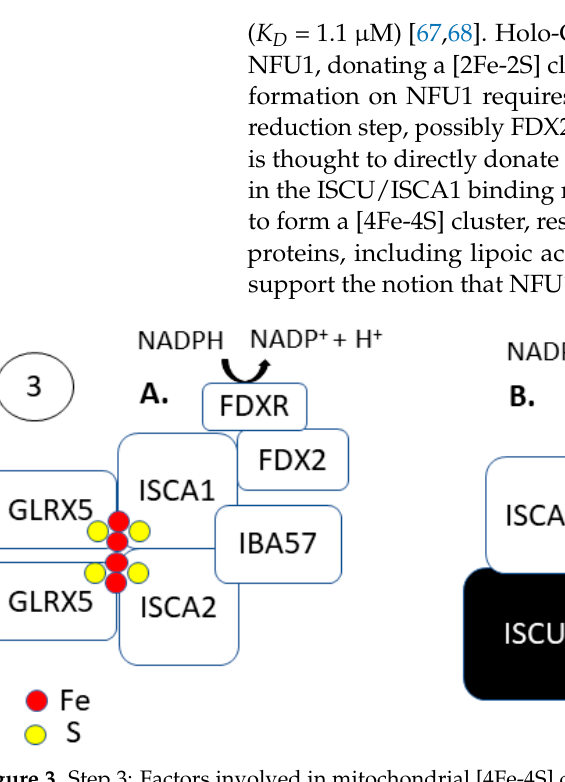
Figure 3. Step 3: Factors involved in mitochondrial [4Fe-4S] cluster formation. ( A ) Following [2Fe-2S] cluster formation and transfer to GLRX5, 2 molecules of holo-GLRX5 can bind with ISCA1/2. The formation of a heterodimer of [2Fe-2S]-ISCA1/2 allows for IBA57 and FDX2 dependent [4Fe-4S] assembly. ( B ) Following [2Fe-2S] cluster formation on ISCU, holo-ISCU and holo-ISCA1 can bind at the C-terminal domain of NFU1 to allow for [4Fe-4S] cluster formation on NFU1 in an FDX2-dependent manner. ( C ) Following the transfer of a [2Fe-2S] cluster from ISCU to GLXR5, a holo-GLXR5-BOLA3 complex can donate a [2Fe-2S] cluster to NFU1 for [4Fe-4S] cluster assembly. This is reduction-dependent and likely dependent on FDX2.